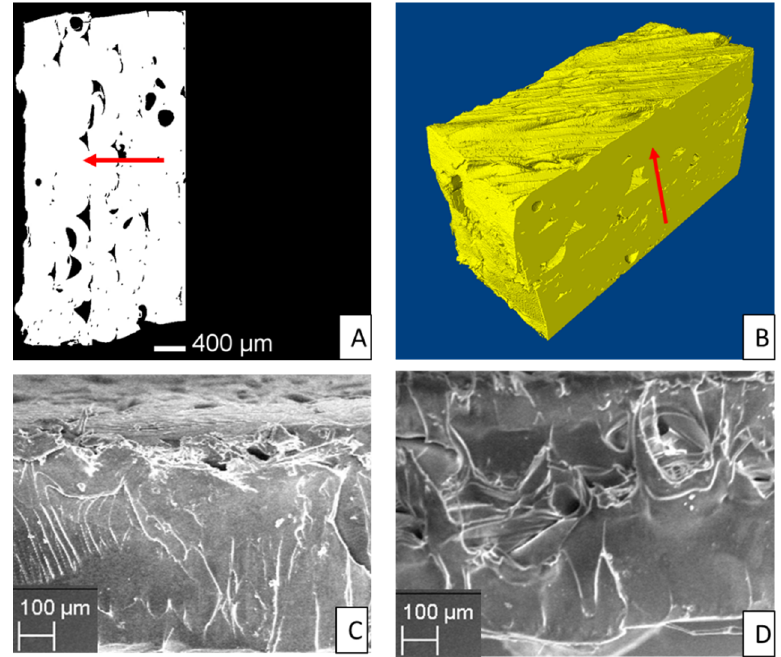
Figure 8. Micro CT analysis; segmented cross section ( A ) and 3D model from CT ( B ). Red arrows indicate the deposition direction. SEM images of the cross section of PET_3D sample ( C and D ).